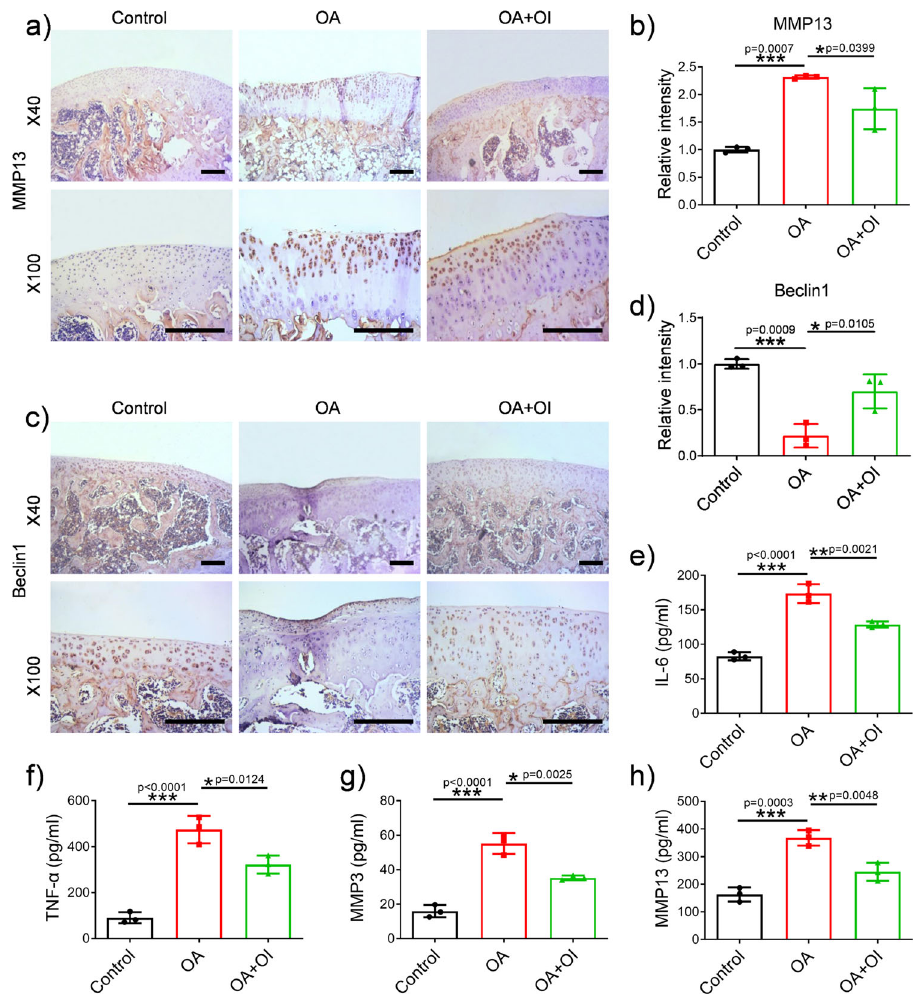
Fig. 6 OI induced autophagy marker expression and reduced in fl ammatory cytokine expression in rats with OA. a – d Representative images of immunohistochemistry and the quanti fi cation of MMP13 and Beclin-1 expression (scale bar = 250 μ m). e – h The concentrations of IL-6, TNF- α , MMP3 and MMP13 were evaluated by ELISA ( n = 3). The error bar is SD. The data are expressed by mean ± SD. * P < 0.05, ** P < 0.01, *** P <